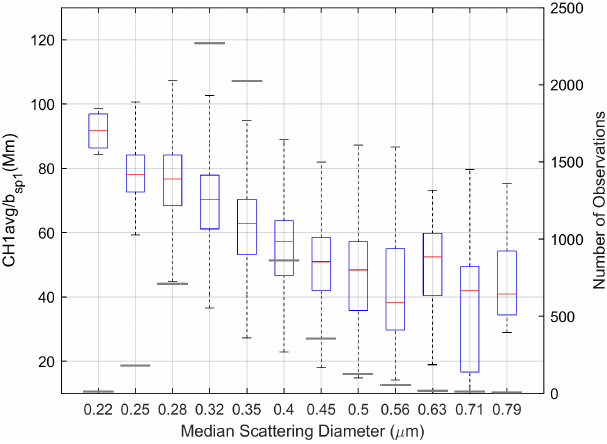
Figure 11. Observed decrease in CH1avg /b sp1 ratio as a function of MSD values. MSD values were selected based on a log scale but plotted equally spaced from each other to maintain uniformity in the dimensions of the box-and-whisker symbol. The red line represents the median value, and the bottom and top of each box are the first and third quartile values. Extremes shown on each box are the 2nd and 98th percentiles. Black horizontal lines for each MSD value are the number of observations in the respective MSD